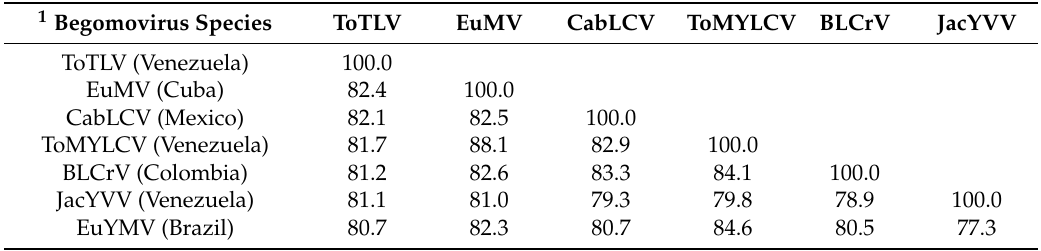
Table 1. Percent nucleotide sequence identity between Tomato twisted leaf virus (ToLTV) genome and closely related begomoviruses.